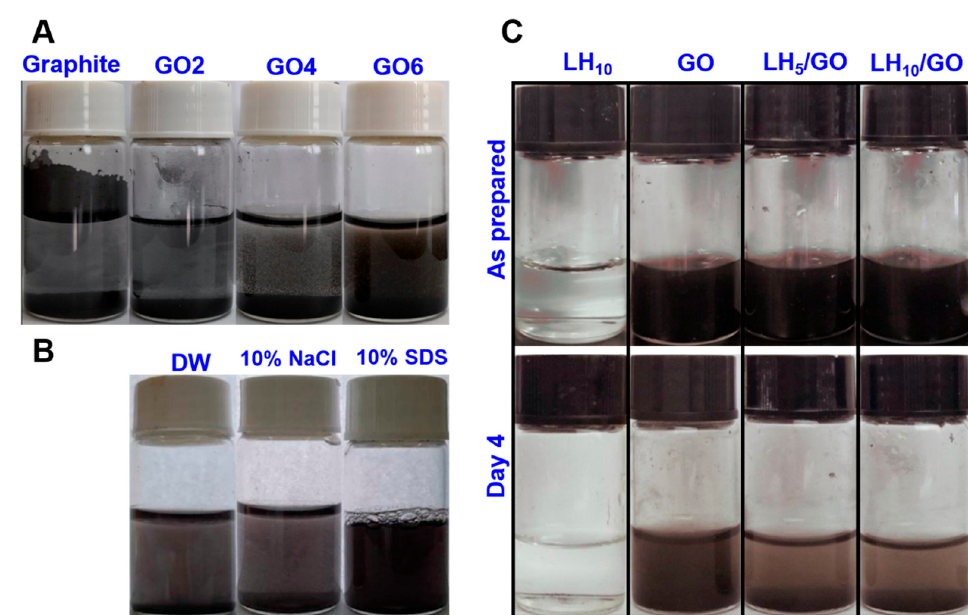
Figure 2. ( A ) Solubility of graphite and GOs after 12 h dispersed in deionized water. ( B ) Solubility of GO6 after 12 h dispersed in surfactant and salt. ( C ) Investigation of ion complexes formulation of graphene oxide and lidocaine hydrochloride. Figure 2C affirms the interaction of LH and GO by means of ionic